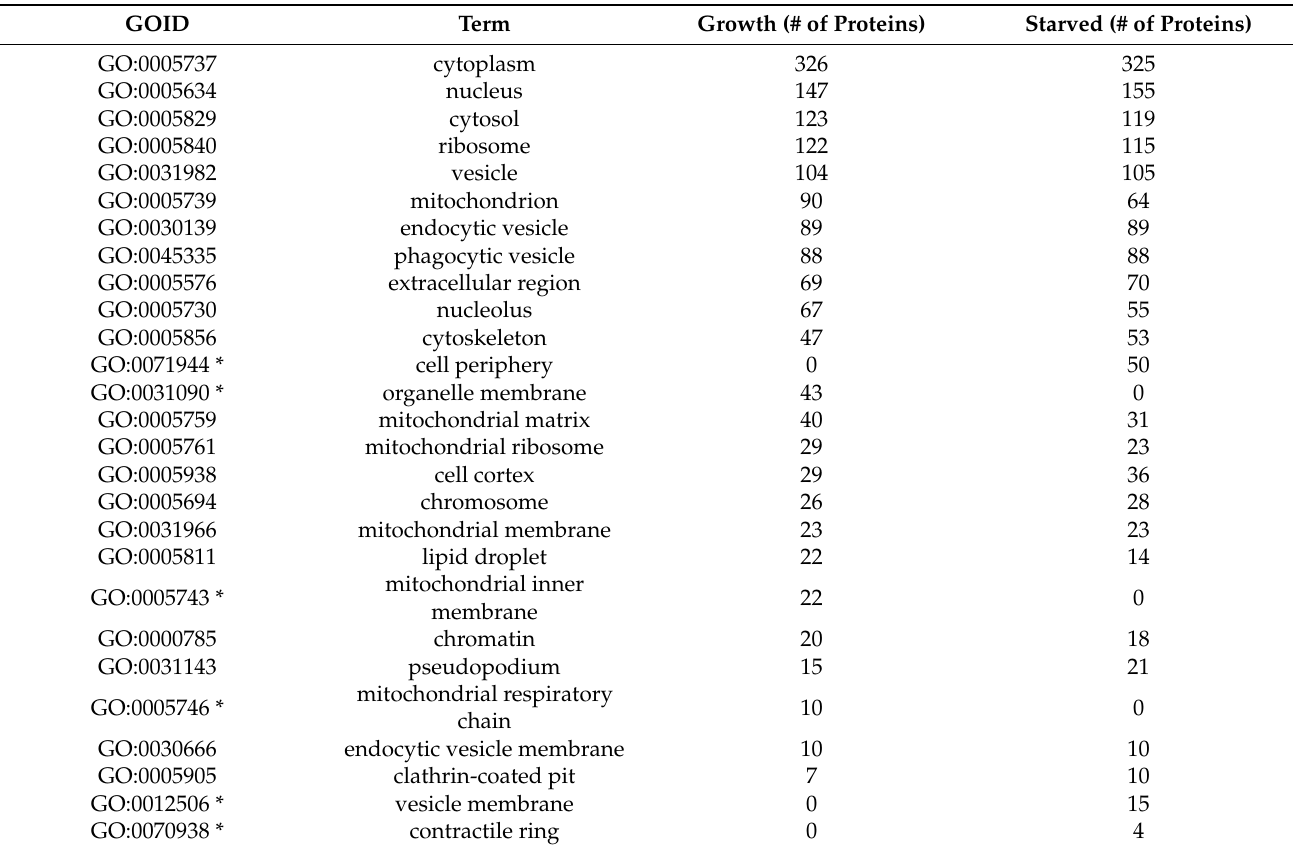
Table 5. Gene ontology (GO) term enrichment analysis summary (cellular component) for proteins identified in calmodulin (CaM) immunoprecipitation (IP) fractions. Displaying only those results with p < 0.05.